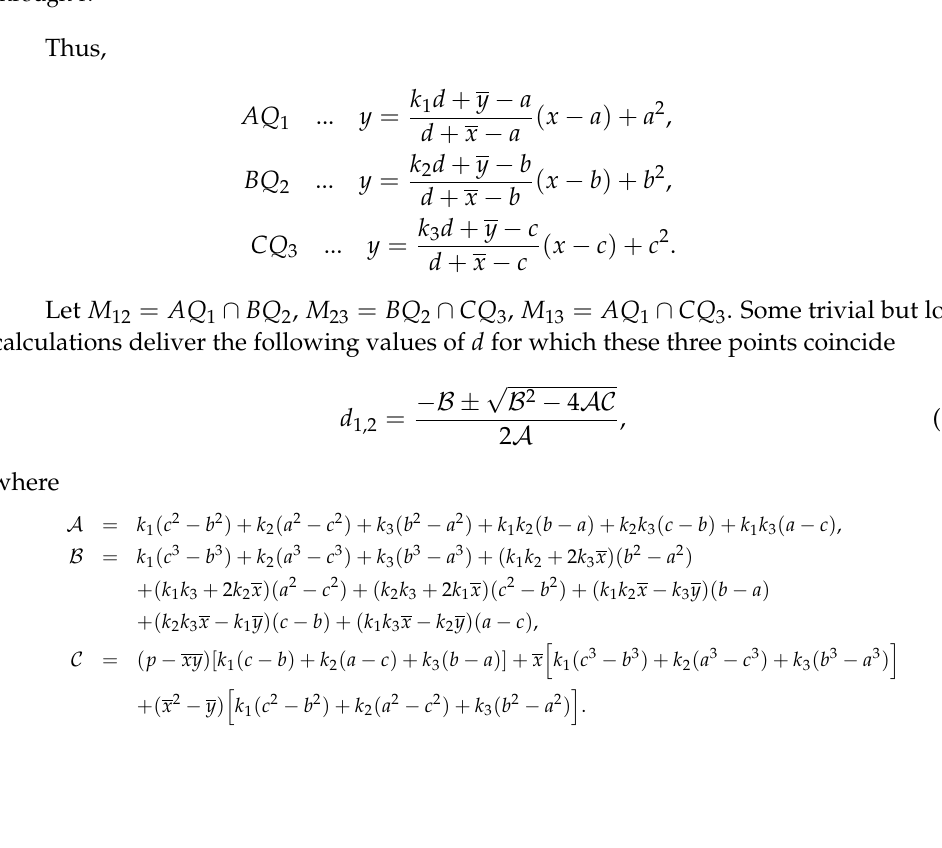
Figure 2. Generalized Gergonne points G 1 , G 2 for the triangle ABC , point I and lines q 1 , q 2 , q 3 through I